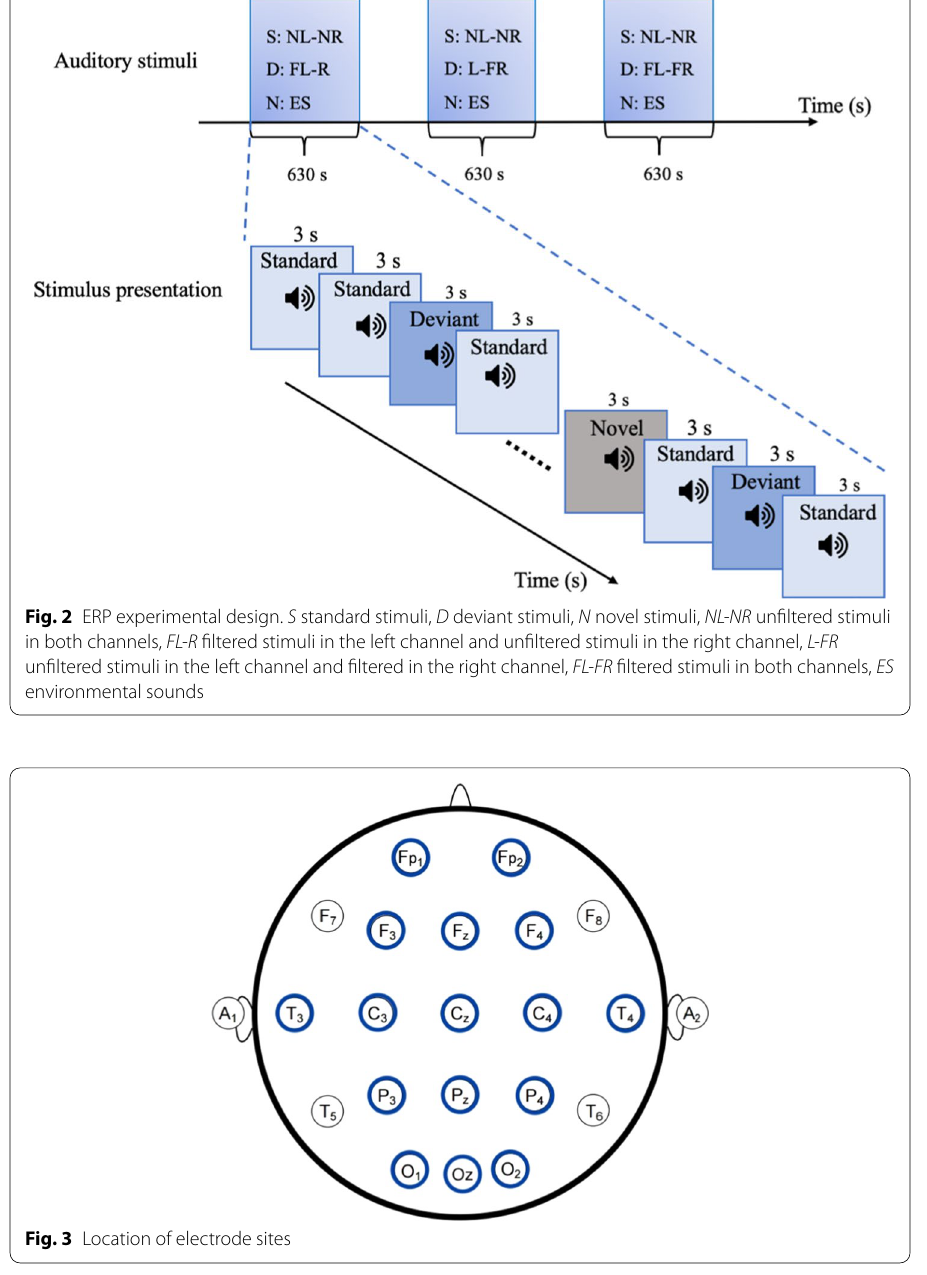
band-pass filter of 0.1–70.0 Hz was adopted to filter the off-line data, and artifacts above 100 μV were rejected.